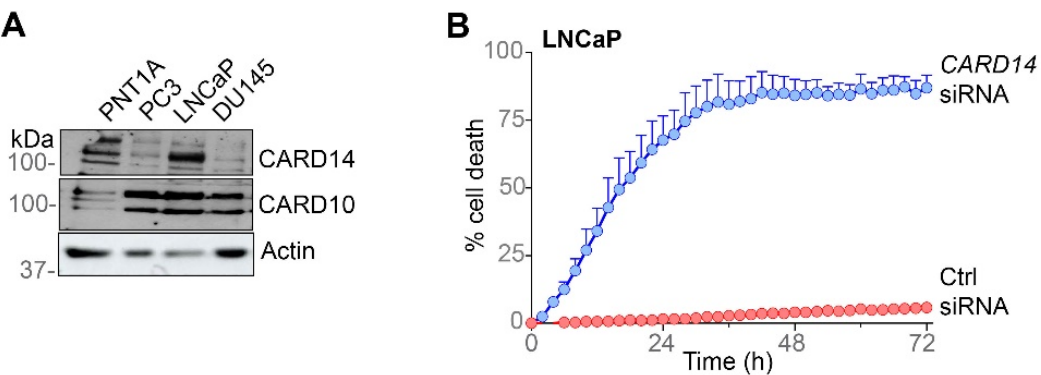
Figure 2. CARD14 is essential for PCa cell survival. ( A ) CARD10 and CARD14 expression profile in PCa cell lines analysed by western blot. Actin expression was used as a loading control. ( B ) Cell death in function of time upon knock-down of CARD14 in LNCaP cells. The number of dead cells was quantified using SYTOX green staining and the Incucyte Live-Cell Analysis System. Results are representative of three independent experiments. Error bars represent means ± SEs.